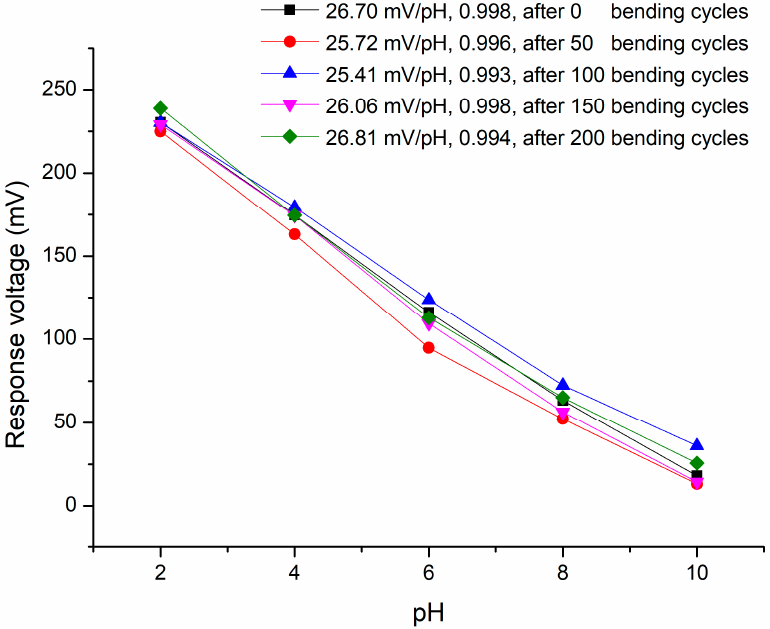
Figure 10. The average sensitivity and linearity of the pH sensor after 0, 50, 100, 150, and 200 bending cycles. bending